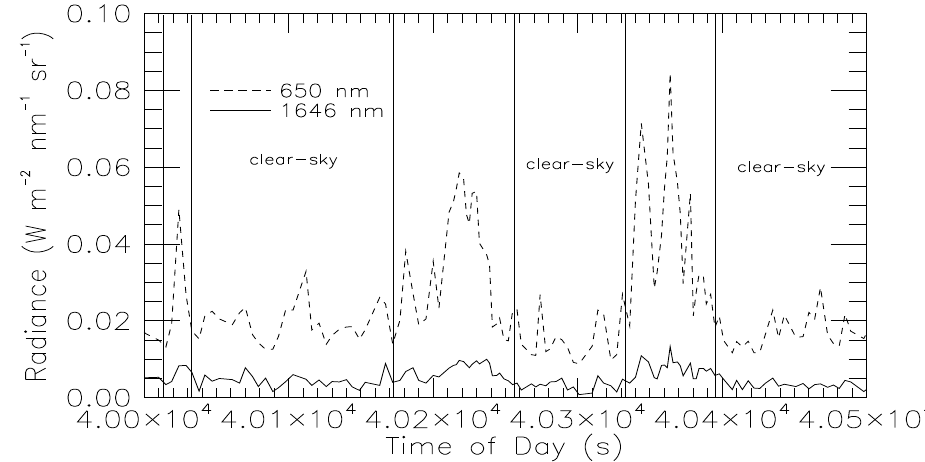
Fig. 4. Example time series (UTC) of HALO-SR radiance measurement reflected by the cirrus on 3 November 2010 for two wavelengths. 0.02 and 0.08 Wm − 2 nm − 1 sr − 1 for the cloudy regions and 0.02 and 0.04 Wm − 2 nm − 1 sr − 1 during clear-sky 19